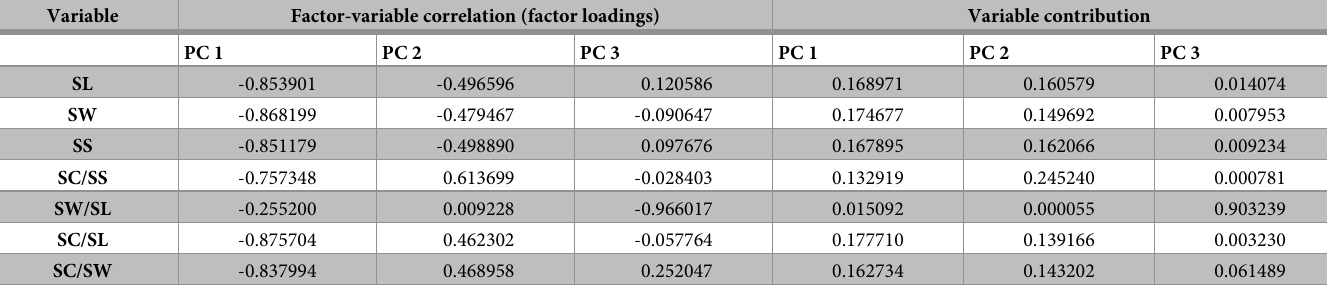
Shell morphotypes were unevenly distributed among sexes ( Gadj = 36.828; P < 10 − 5 ; df = 6) and among sites ( Gadj = 8.433; P < 0.05; df = 3). Male shells and intersex shells were monomorphic and were found only in cluster 3 while female shells were polymorphic with 86% of the shells distributed among clusters 1, 2 and 4. Only 14% of the females belonged to cluster 3. The population in O Grove presented all of the four morphotypes with a predomi- nance of the cluster 2 morphotype for females, while in El Arbeyal the cluster 2 morphotype was absent (Fig 3). The frequency of the different shell morphotypes did not vary among years in O Grove ( Gadj = 4.268; P > 0.05; df = 3). Since SW/SL, SC/SS and SC/SL explained the highest variance for PC 3, PC 2 and PC 1 respectively, these explanatory variables (untransformed) were used to test for significant Table 3. Correlation of the shell variables with the extracted PC and variable